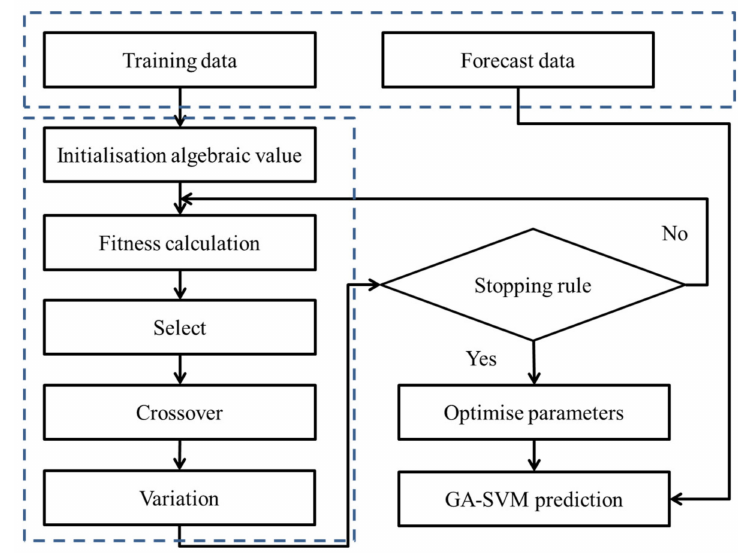
Figure 1. Flowchart of genetic algorithm–support vector machine (GA-SVM) parameter